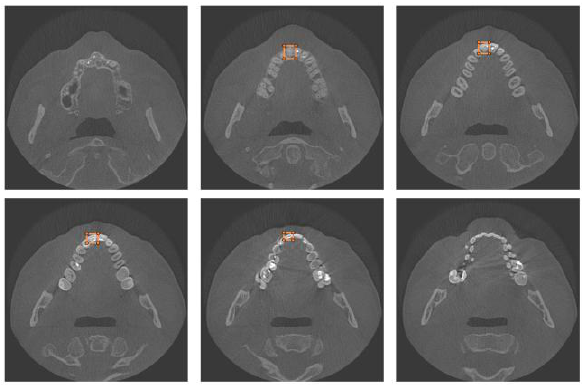
Figure 2. Automatic ROI detection in